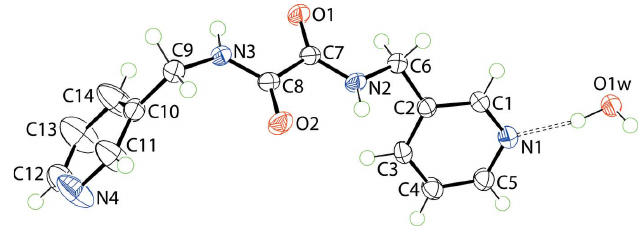
Figure 1 The molecular structure of the constituents of (I) showing the atom- labelling scheme and displacement ellipsoids at the 70% probability level. The water-O—H (cid:2)(cid:2)(cid:2) N(pyridyl) hydrogen bond is indicated by the dashed line.